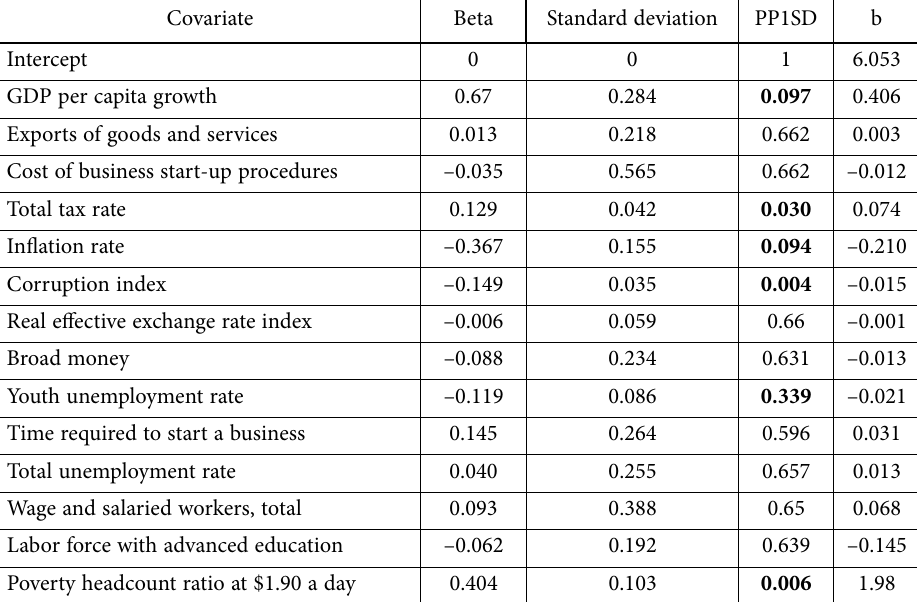
Table 1. Marginal Posterior Summary Estimates for generalized ridge regression in case of Poland (source: own results)